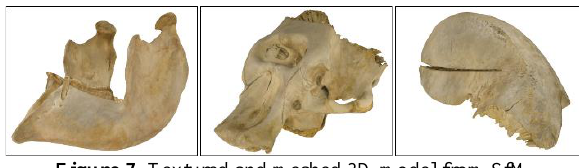
Figure 7. Textured and meshed 3D model from SfM.